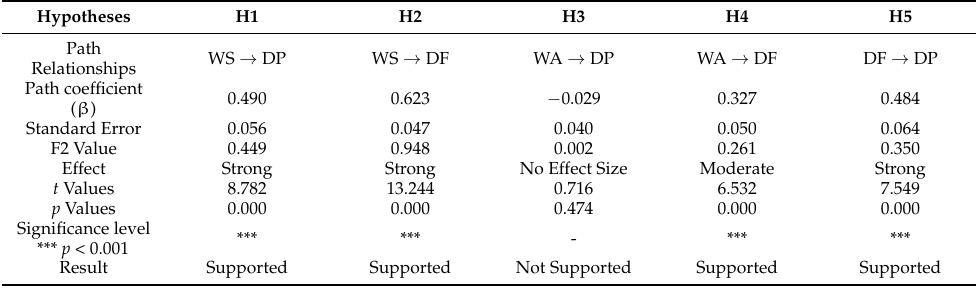
Table 5. Direct effect